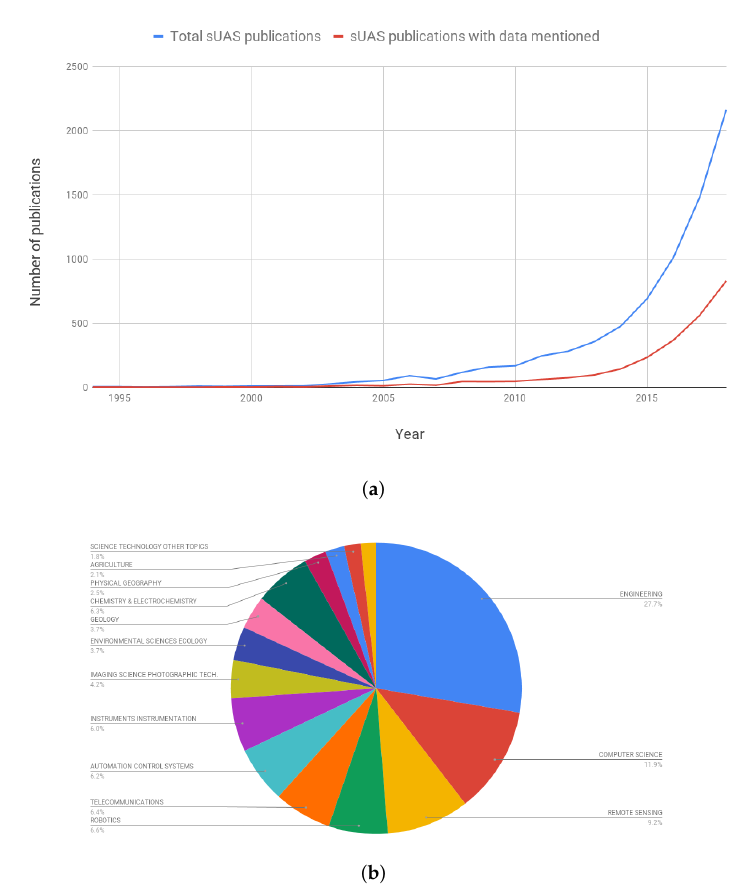
Figure 1. Graphs depicting growth and distribution of publications. In ( a ), as small Unmanned Aircraft Systems (sUAS) have become more prevalent as platforms for scientific data collection, there has been a corresponding increase in their prominence within the academic peer-reviewed literature. This graph shows this growth in blue, with the number of publications found in a Web of Science literature search on the topic of sUAS. By comparison, the number of sUAS publications that also referenced the management of data, is shown in red at a much lower rate. Search terms used in the search for papers referencing sUAS included: “unmanned aerial systems”, “unmanned aerial system”,